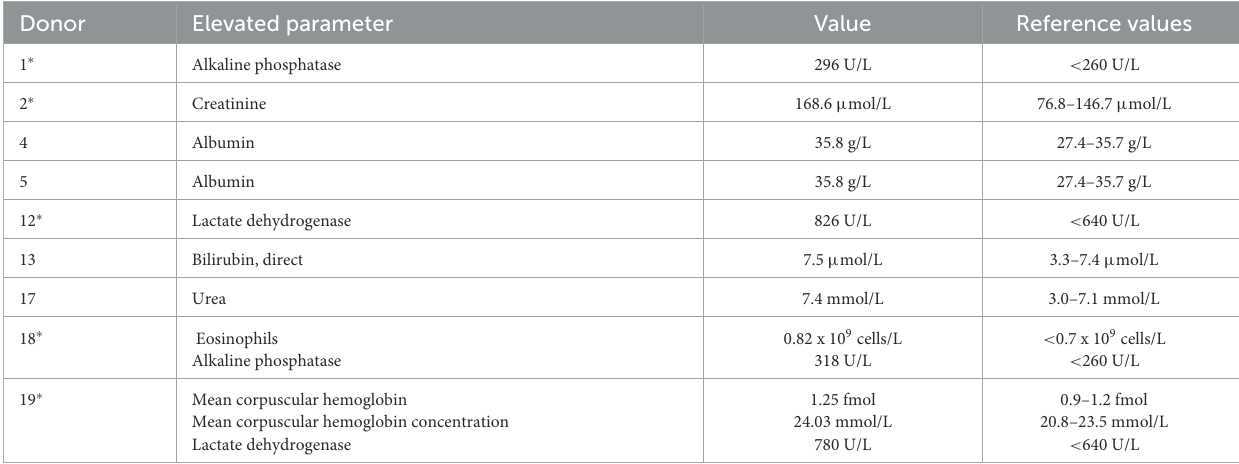
TABLE 1 Findings in blood counts and blood chemistry.